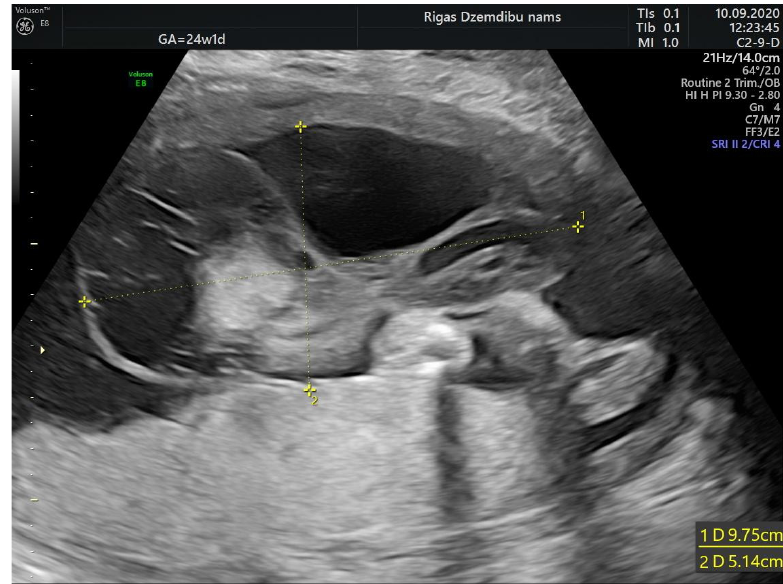
Figure 1. Tumor appearance at 24 + 1 weeks.